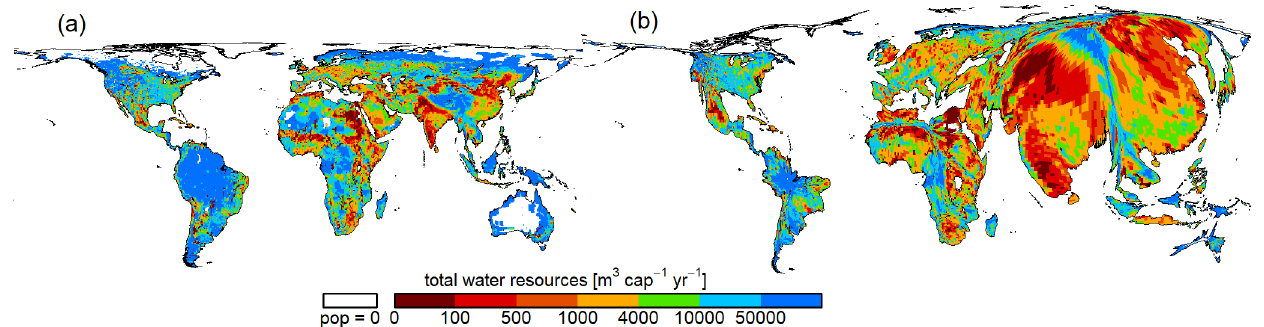
Figure 14. Water availability indicator per capita renewable water resources Q r , out , lta , nat (m 3 cap − 1 yr − 1 ) for 1981–2010 visualized in (a) an equal area projection and (b) as a cartogram with population in 2010 as distorter. In the cartogram each half-degree grid cell is distorted such that its area is proportional to the population of the grid cell.